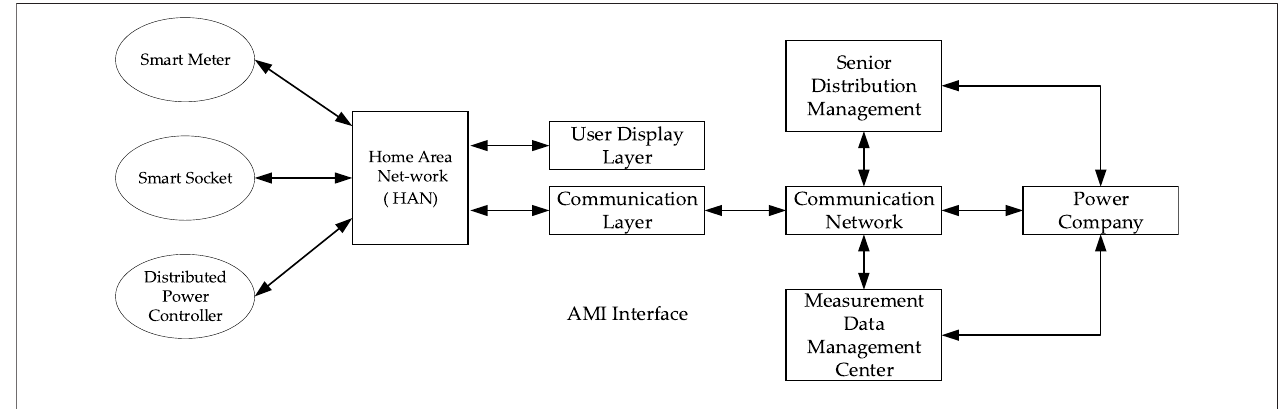
FIGURE 5 | Typical structure of the AMI.